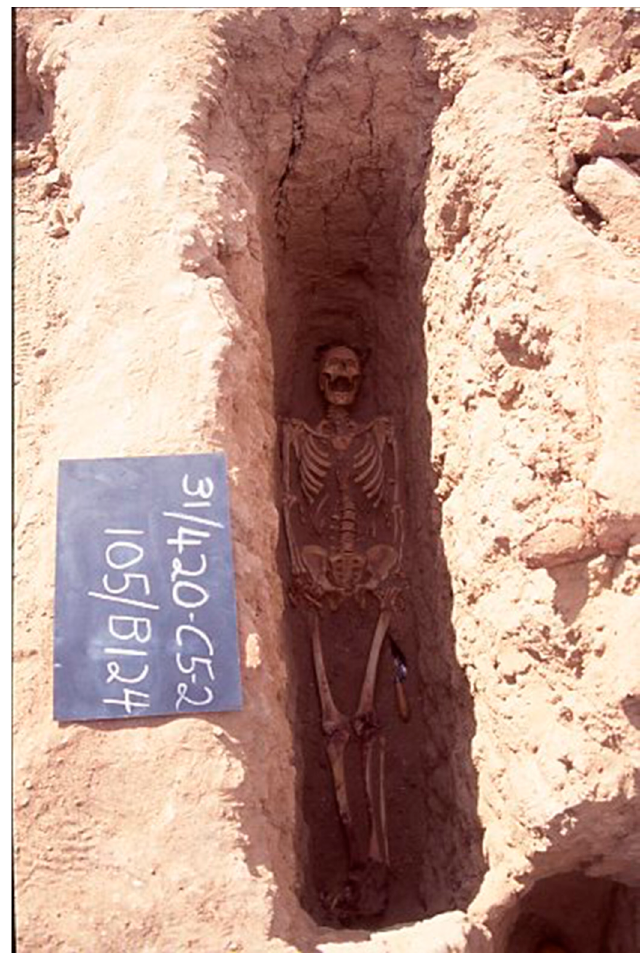
Figure 2. Skeletal remains of Burial 124 (B124).